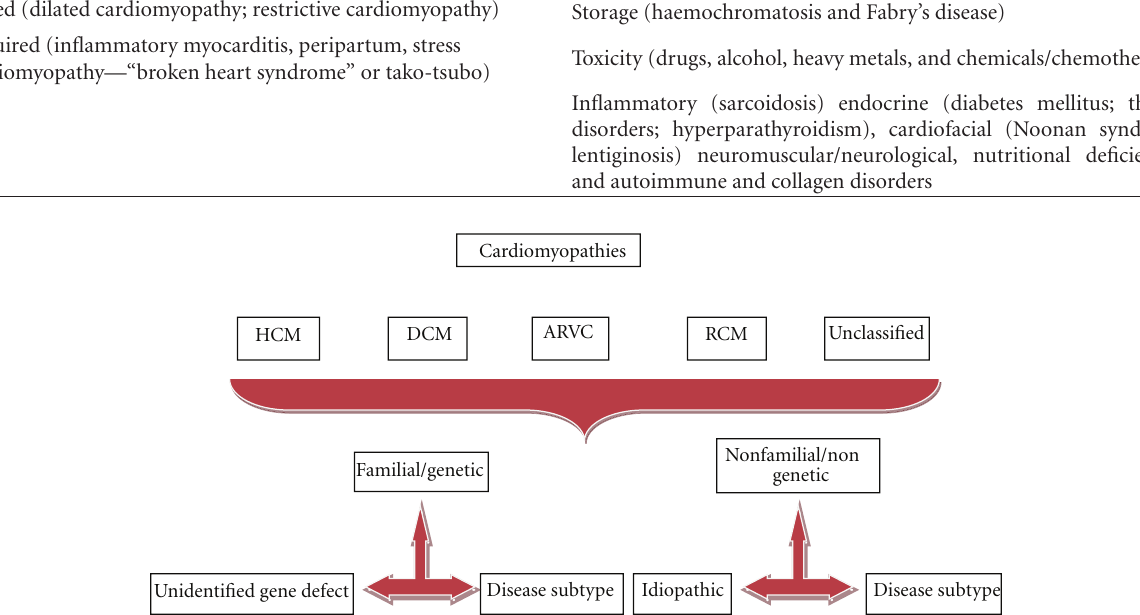
Figure 1: Summary of ESC 2008 Classification [2]. DCM: dilated cardiomyopathy; HCM: hypertrophic cardiomyopathy; ARVC: ar- rhythmogenic right ventricular cardiomyopathy; RCM: restrictive